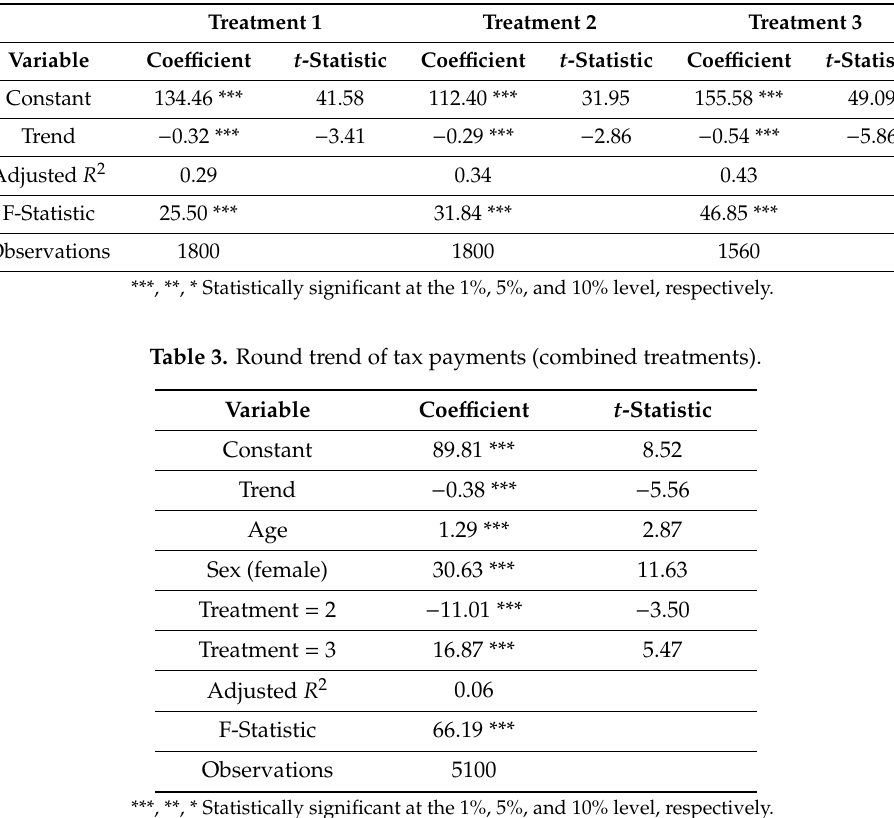
Table 2. Round trend of tax payments in the di ff erent treatments (individual fixed e ff ects).